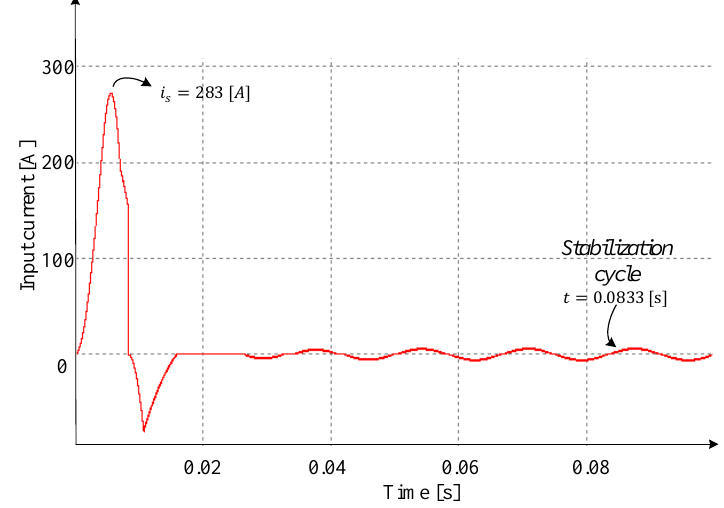
Figure 14. Input current behavior without integral of current error in